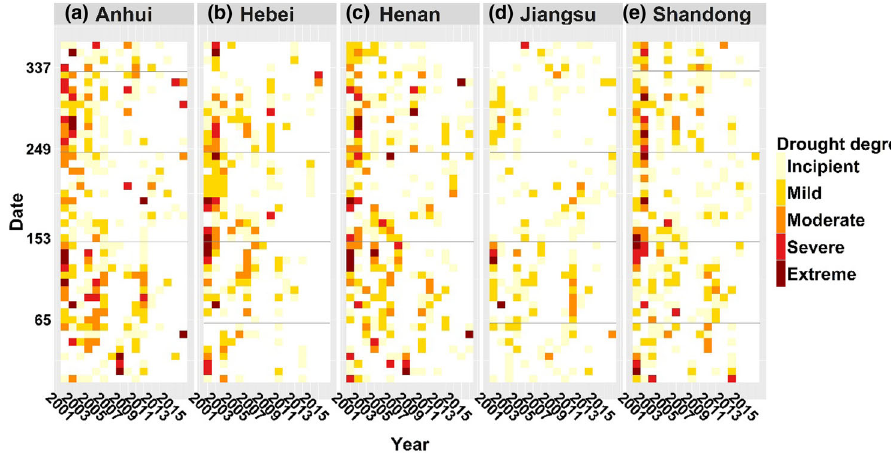
Fig. 3 Temporal distribution of droughts of different intensities in Anhui, Hebei,